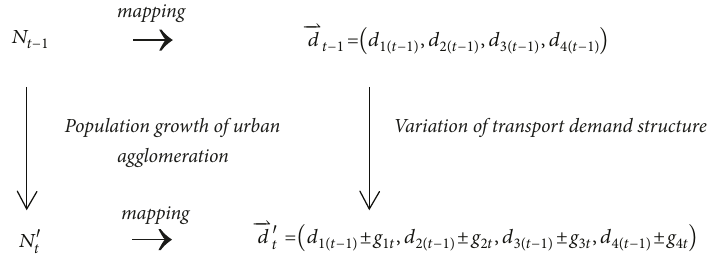
Figure 3: Mapping process from population size to transport